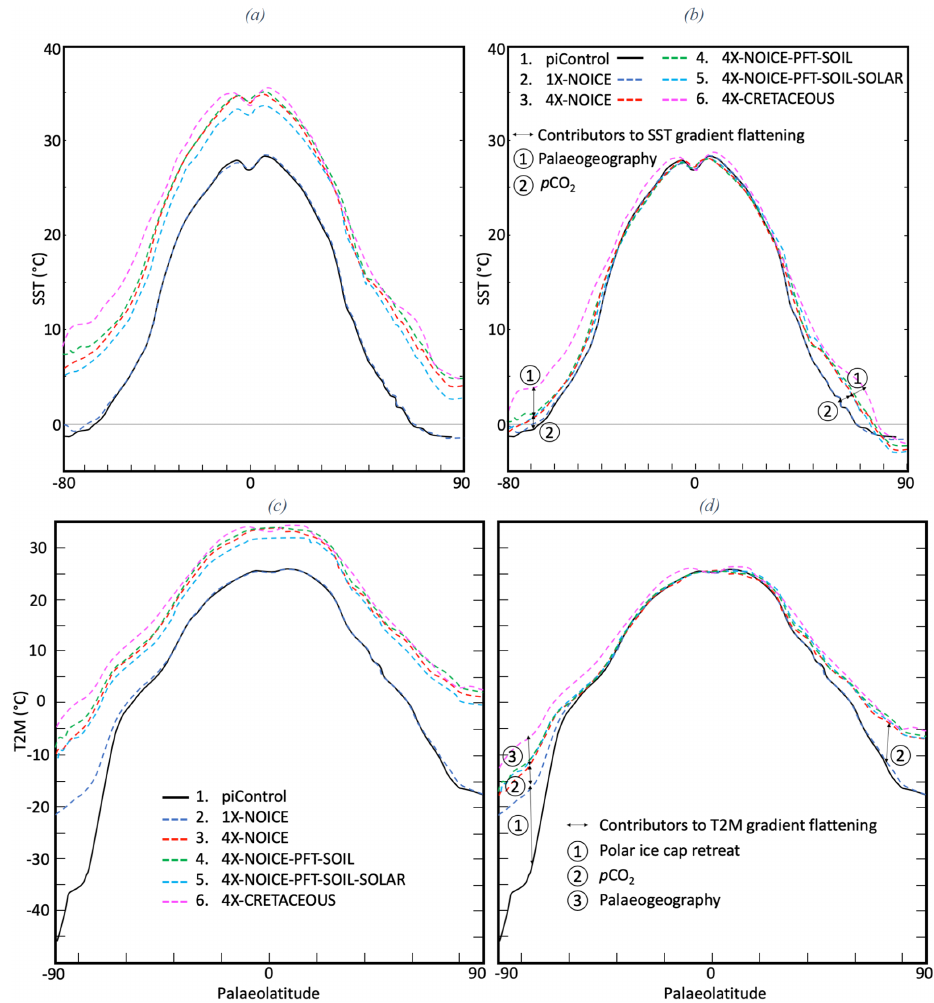
Figure 9. (a) Mean annual meridional sea-surface temperature gradients for all simulations. (b) Same SST curves as (a) but superimposed such that Equator temperatures are equal, allowing to compare the steepness of the curves. (c) Meridional atmospheric surface temperature gradients for all simulations. (d) Same curves as (c) but superimposed such that Equator temperatures are equal.